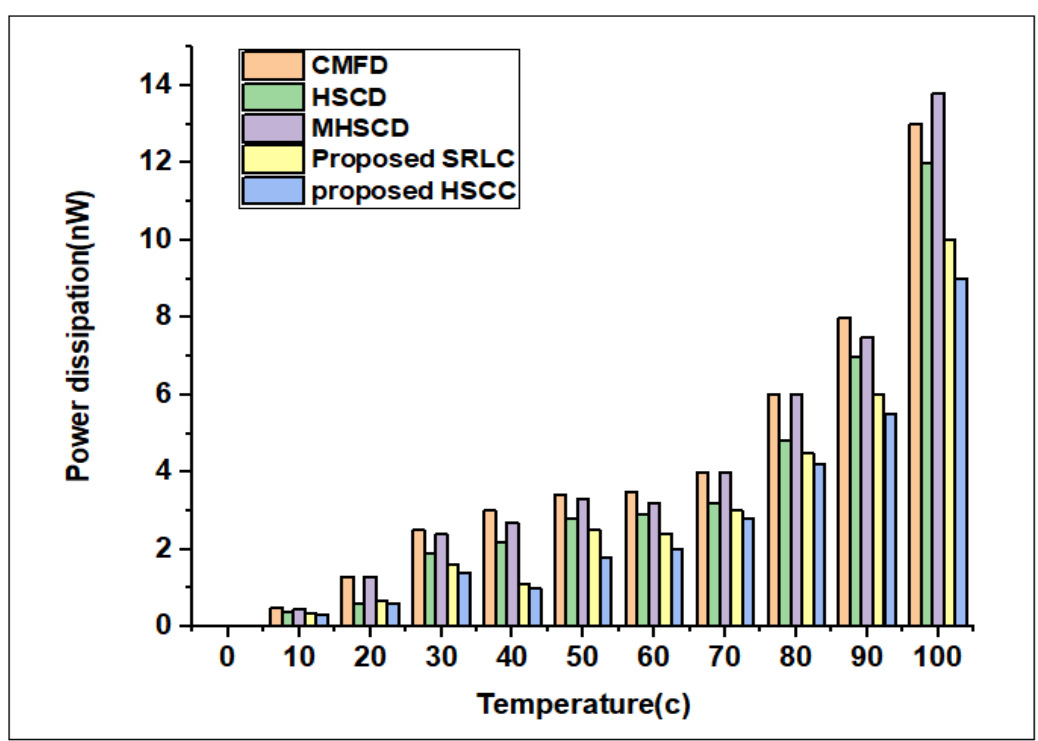
Figure 15. Simulation of power dissipation with the temperature of FinFET-based circuits at 7 nm.